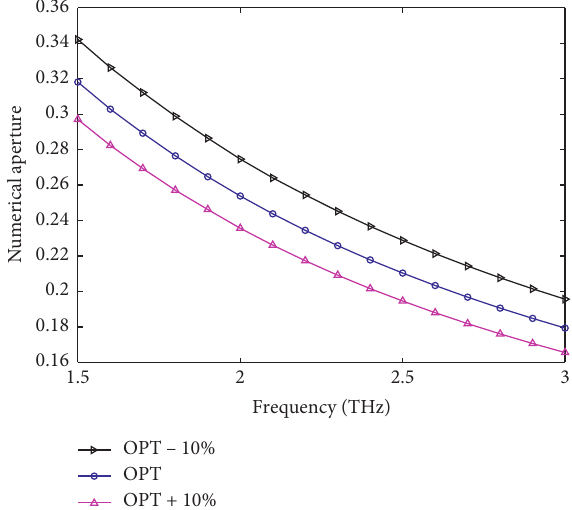
Figure 4: Representation of the numerical apertures for the three models in the THz